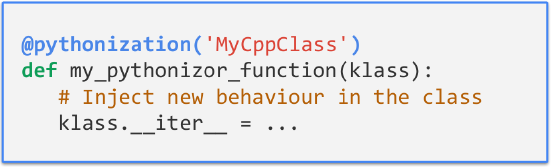
Figure 4: Function that pythonises the MyCppClass user C ++